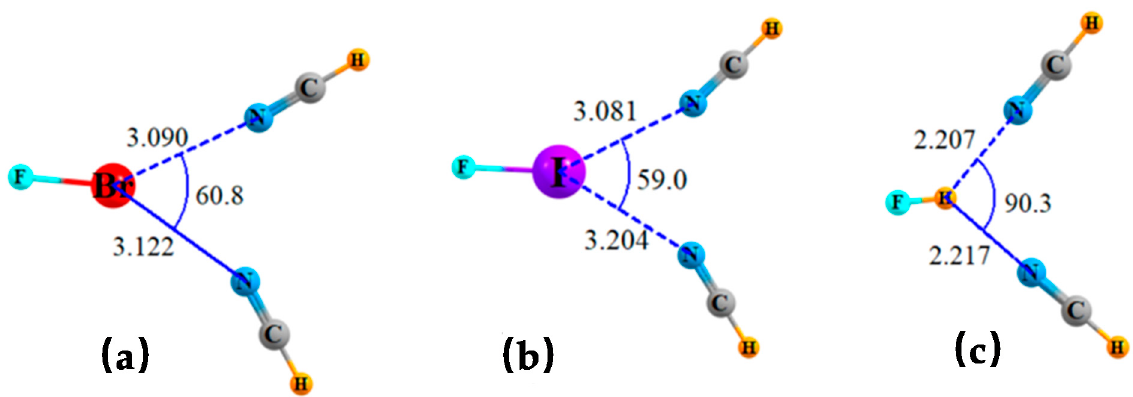
Figure 3. Geometries of triads wherein a pair of NCH bases share a single σ -hole of ( a ) FBr, ( b ) FI, and ( c ) FH, optimized with constraint of equal θ (N ·· X ·· N) angles. Distances in Å and angles in degs.